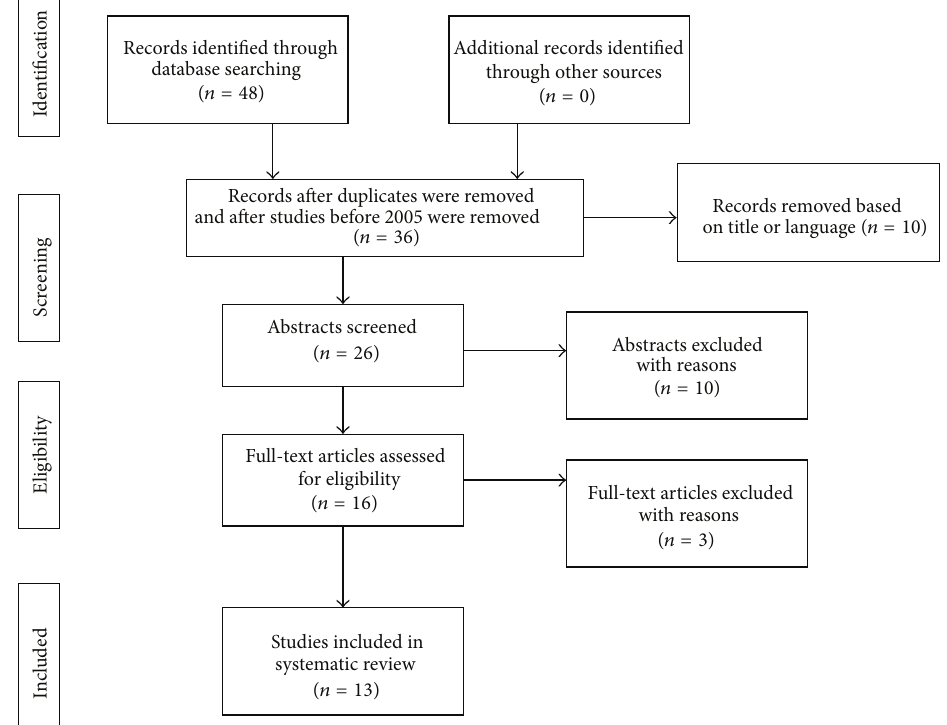
Figure 1: Flowchart of the results of the literature